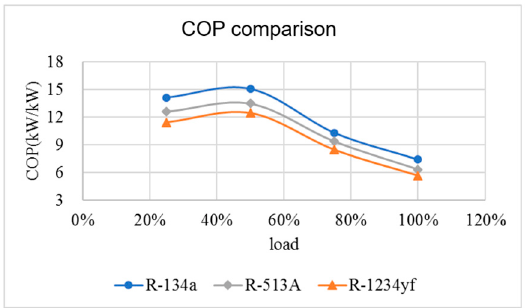
Figure 14. Comparison diagram of COP of refrigerants.